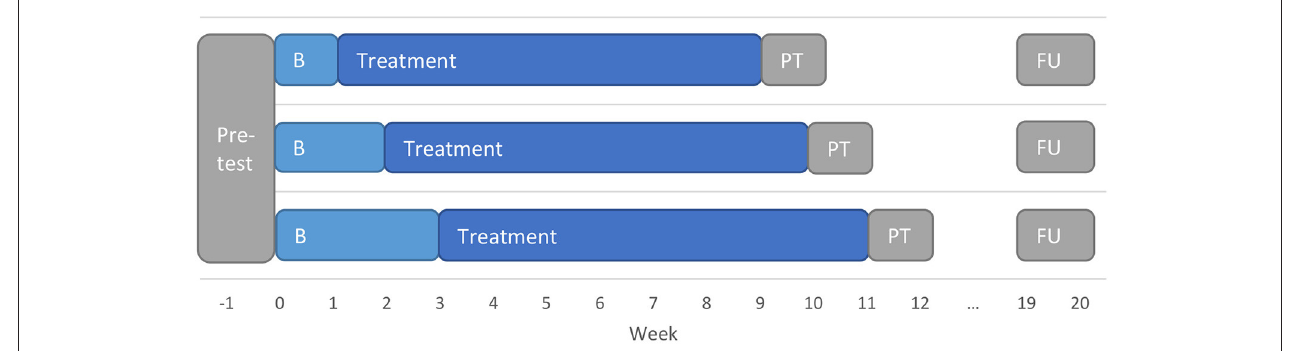
FIGURE 1 | Multiple-baseline design employed in the present study. B, baseline; FU, follow-up; PT, Posttest.